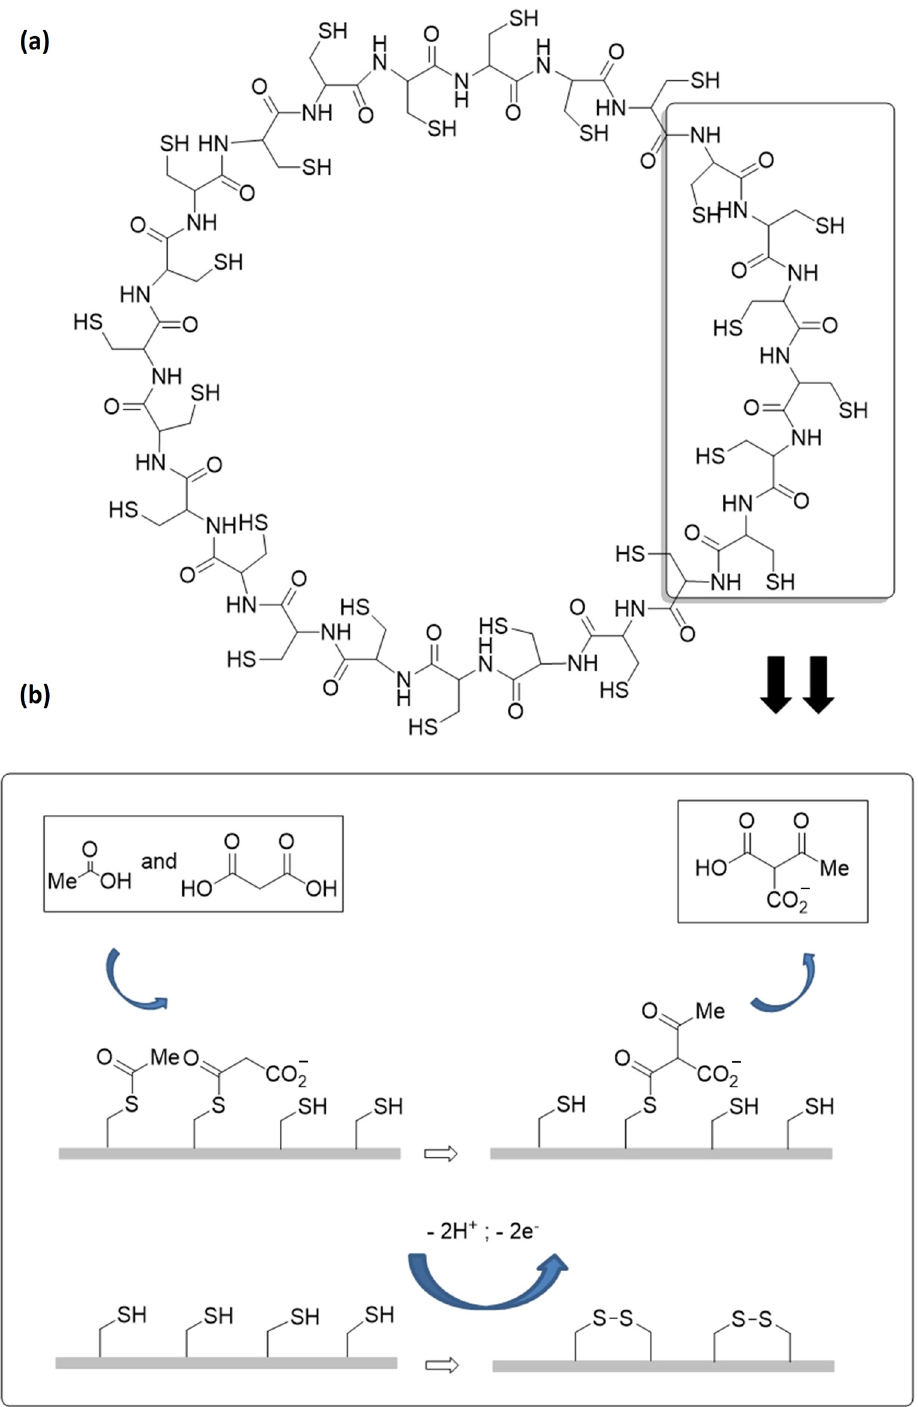
Figure 2. ( a ) Example of a detected polycysteine, starting from Cys-CN; ( b ) proposed catalytic path- ways of thiol-rich peptides in primitive environment. pathways of thiol-rich peptides in primitive